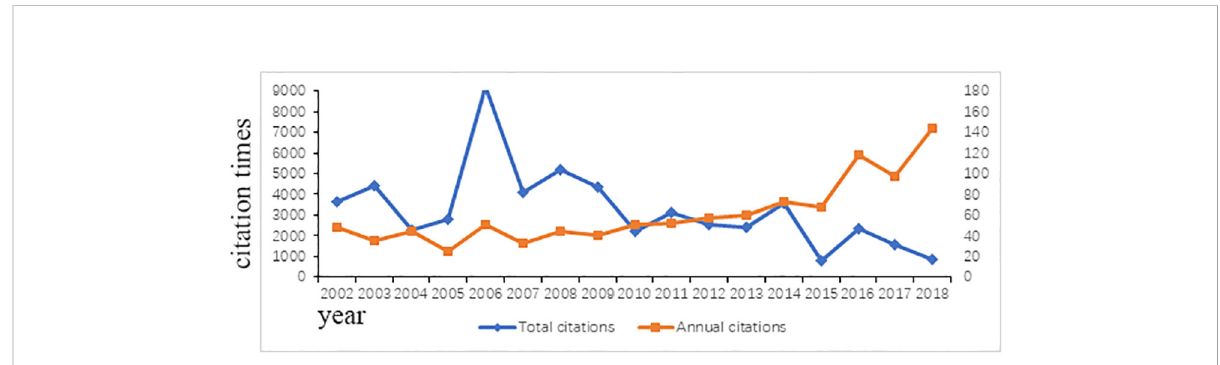
FIGURE 2 The annual total citations and average annual citations. The orange line represents the average annual citations of the published articles in different year, and the blue line represent the average total